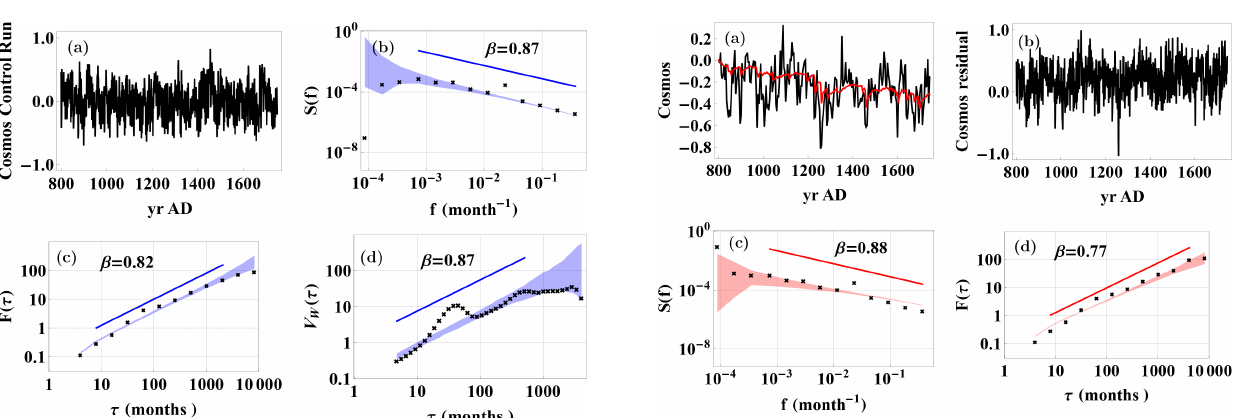
Figure 7. (a) The temperature from the COSMOS control simula- tion. (b) PSD, (c) DFA2, and (d) WVA2 applied to the record. The shaded areas are the 95% confidence range for synthetic fGn with β estimated by PSD, DFA2 and WVA2. The β -values are estimated from the slopes of the straight lines and the range of scales used for estimation is indicated by the length and position of these line segments. The estimated β -values are indicated in the figure.